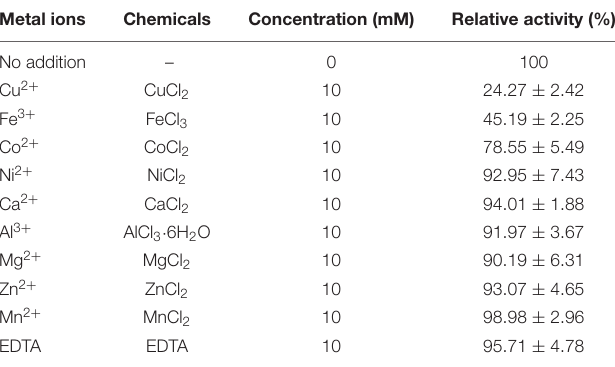
TABLE 1 | Effects of metal ions on the activity of NAGaseA.